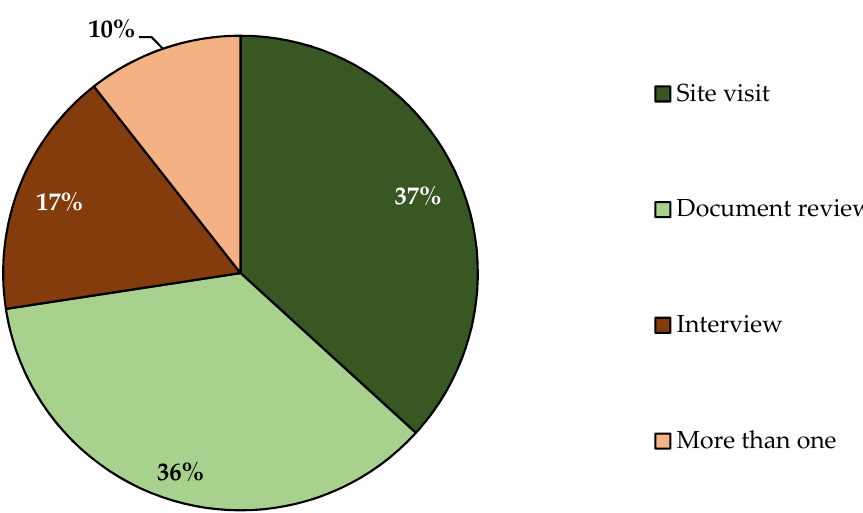
Figure 3. Sources of CAR and observation identifications.